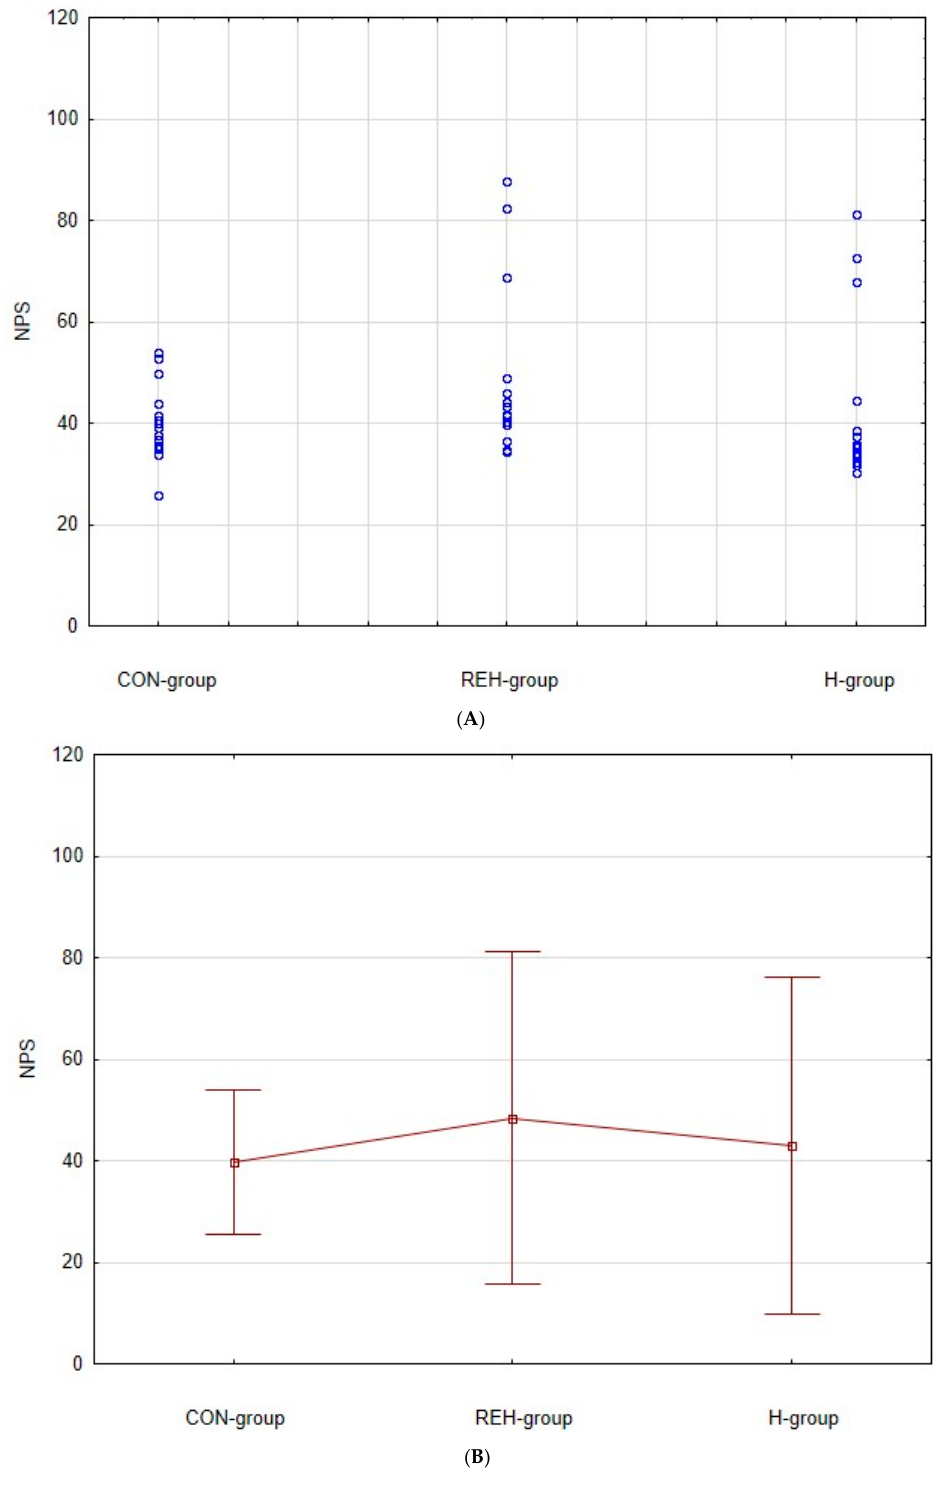
Figure 1. ( A ). NPS initial results: scatterplot CON group versus REH group versus H group. ( B ). NPS initial results means and standard deviations REH group versus CON group versus H group. The patients from the CON group had on average three previous psychiatric hospitalizations (M 2.77, SD 1.60), and the REH group had four (M 4.19, SD 1.17). Almost all the patients lived on a disability pension or other social benefits. A significant proportion of the study participants smoked cigarettes: CON—76.5%; REH—56.3%; non- clinical—66.7%. During the trial, all patients continued their former anti-psychotic treatment (daily dose olanzapine equivalents in milligrams: CON vs. REH: M 19.32 SD 4.97 vs. M 21.28 SD 6.88) [37]. The anti-psychotic treatment pattern was not changed during the experiment. All subjects were administered atypical anti-psychotics (olanzapine, clozapine, quetiapine, risperidone, and aripiprazole), and only some of them additionally received typical ones (sulpiride, perazine, zuclopenthixol, fluanxol, and haloperidol, respectively: CON—11.8%; REH—20.0%). None of the patients had taken anti-cholinergic drugs. The monotherapy involved an average of half of the study participants: CON group—47.1%; REH group—56.3%. 2.3. Outcome Measures The examinations were performed twice, at the beginning (T1) and after a period of 3 months (T2).